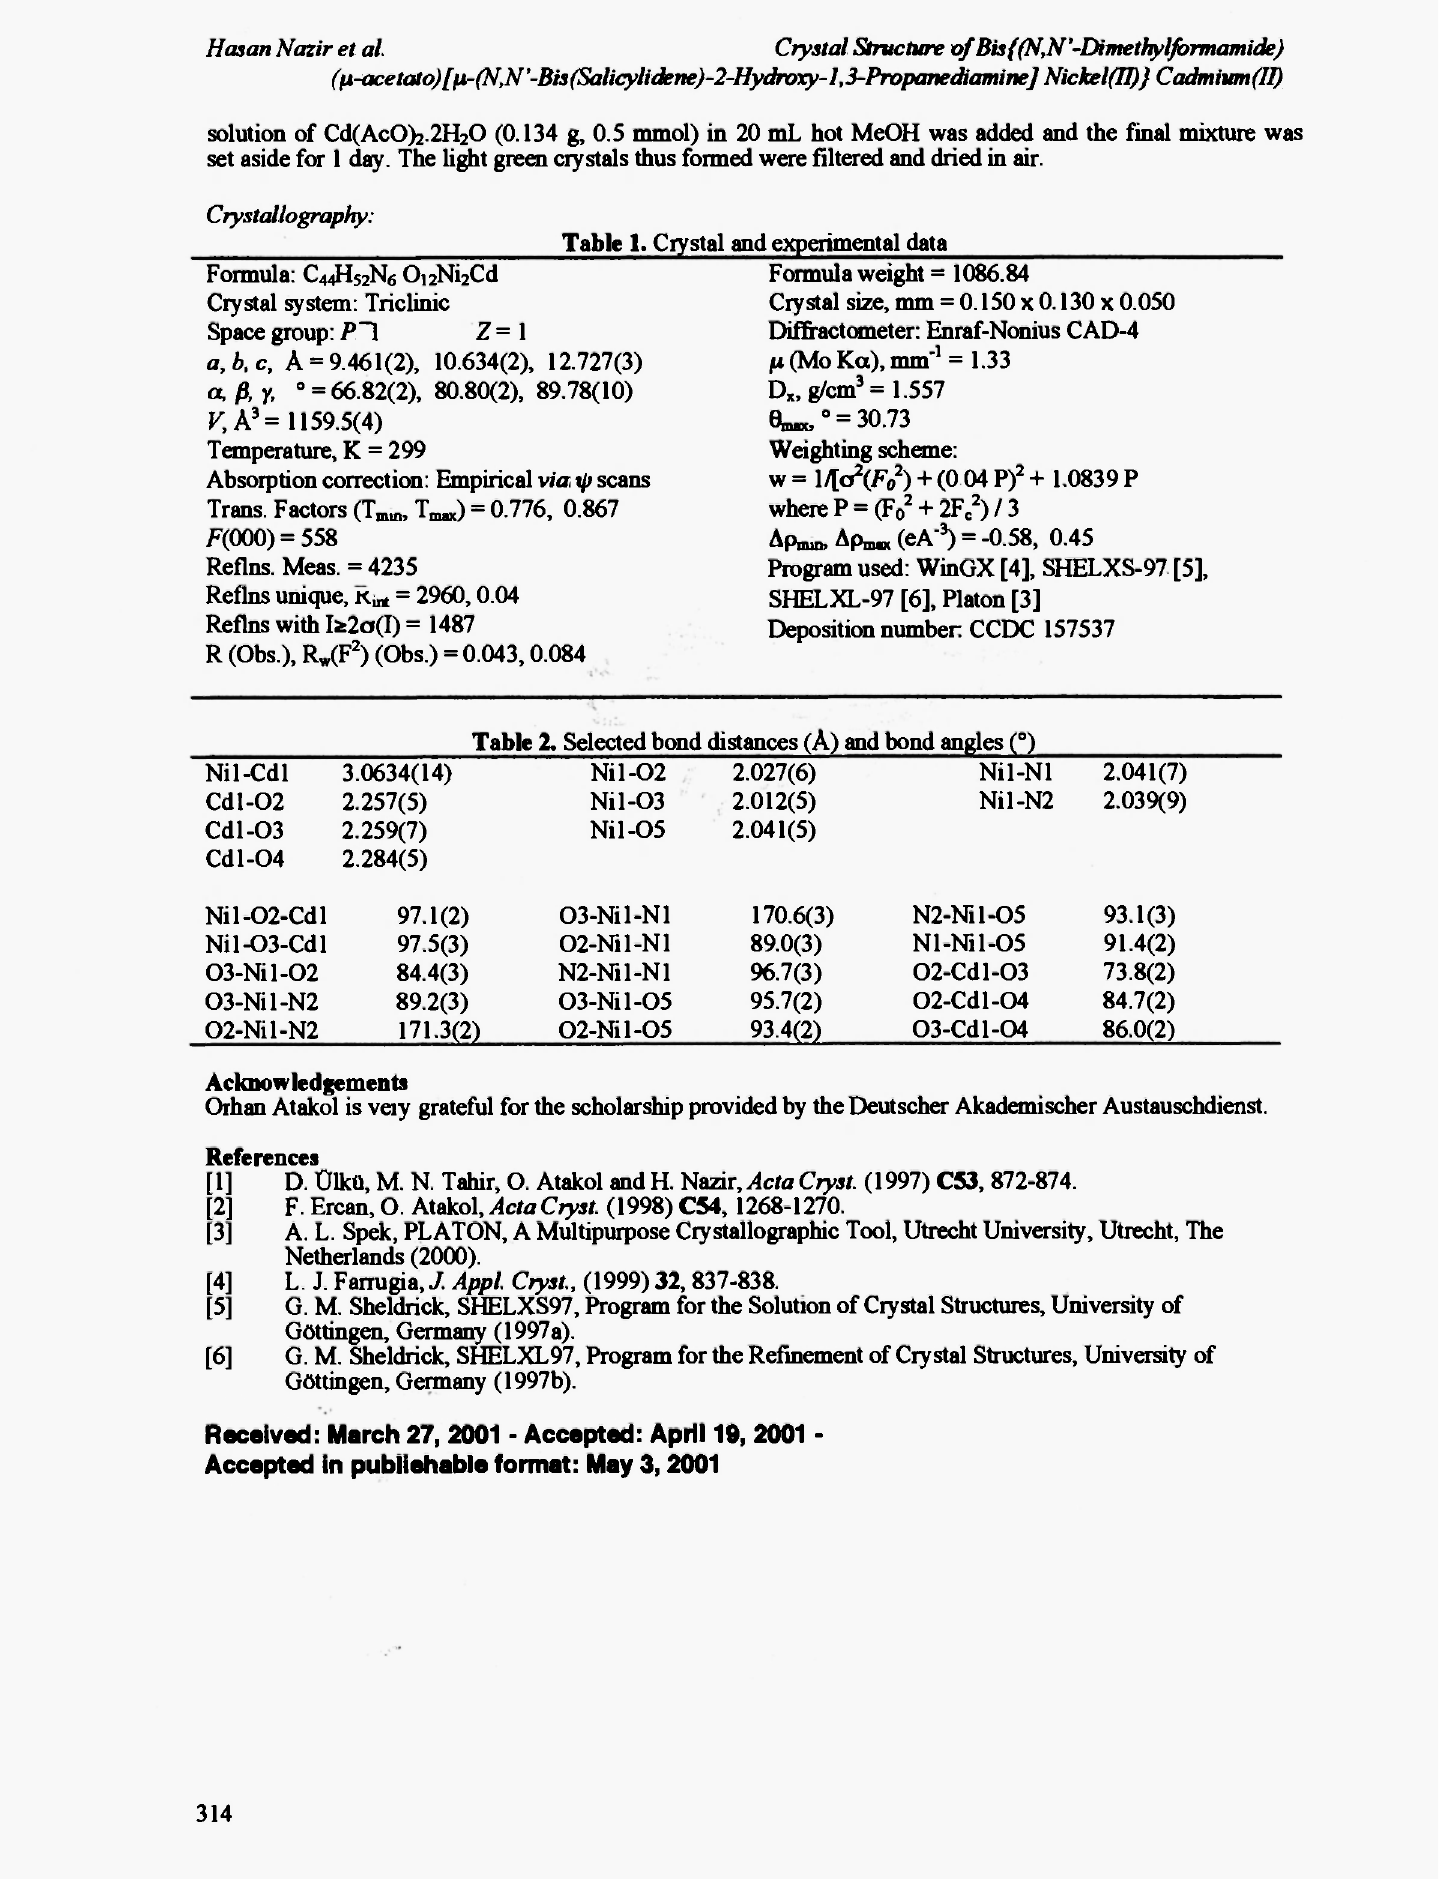
Table 1. Crystal and experimental data